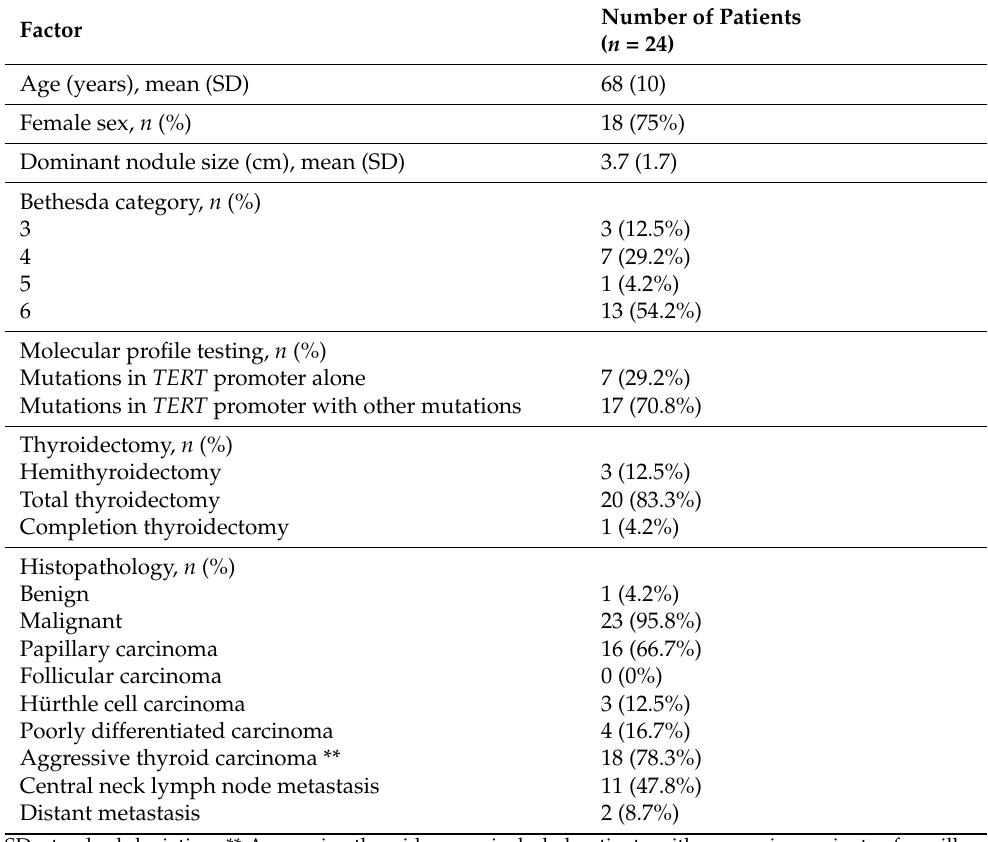
Table 1. Baseline characteristics.